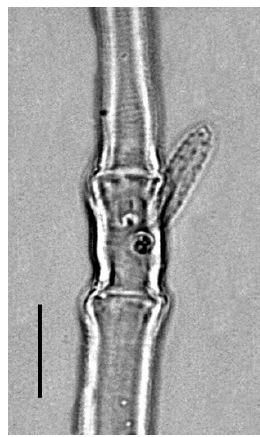
Figure 23. Neophyllobius muscantribii . Female. Genu II. Scale bar: 50 μ m.